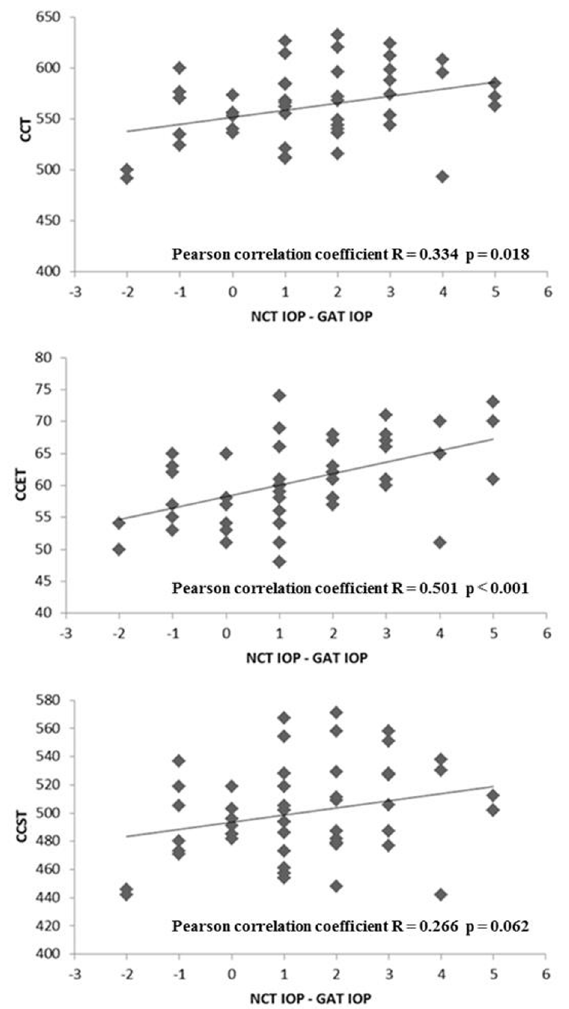
Fig 3. (A) IOP difference between CCT and IOP measured by GAT and NCT. (B) Correlation between GAT IOP and NCT IOP difference and CCET. (C) Correlation between GAT IOP and NCT IOP difference and